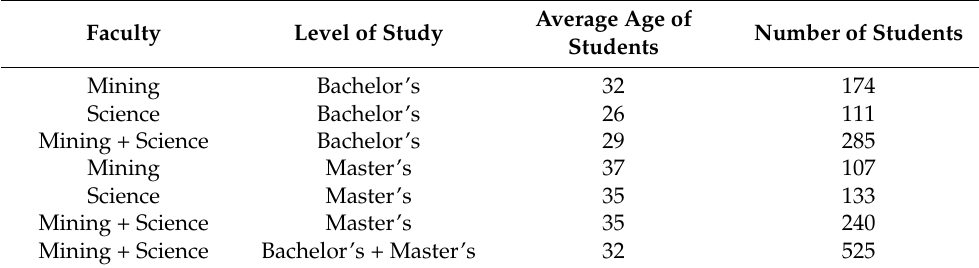
Table 4. The number of students who answered the questionnaire from the Mining and Science Faculties of the University of Petros ani. , Average Age of Number of Students Faculty Level of Study Students Mining Bachelor’s 32 174 Science Bachelor’s 26 111 Mining + Science Bachelor’s